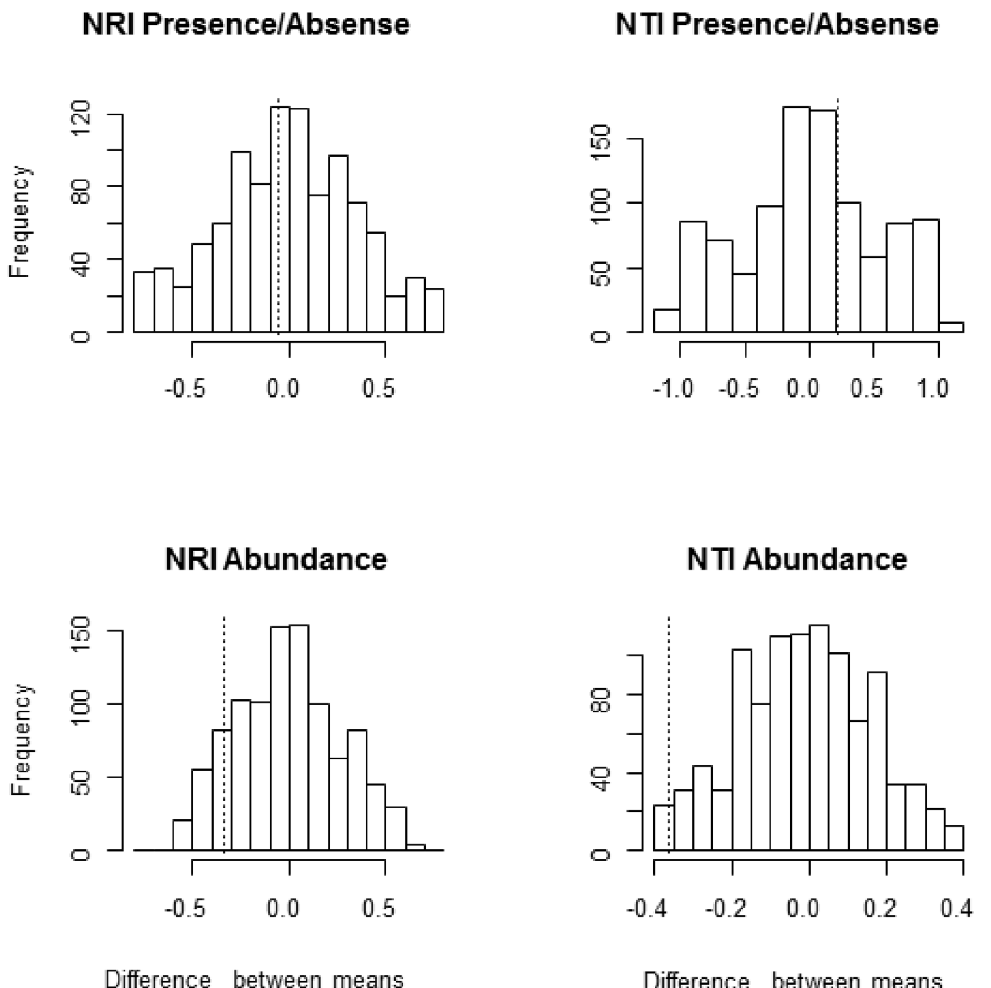
Fig 3. NRI and NTI values between seasons. Permutation test using mean difference in indices of phylogenetic structure of anuran communities, NRI and NTI, in rainy and dry seasons in the Nhecolândia region, Pantanal wetland, Brazil. The dashed lines indicate the actual mean difference between the periods (nri p/a p = 0.102, nti p/a p = 0.384, nri abd p = 0.076, nti abd p = 0.006).